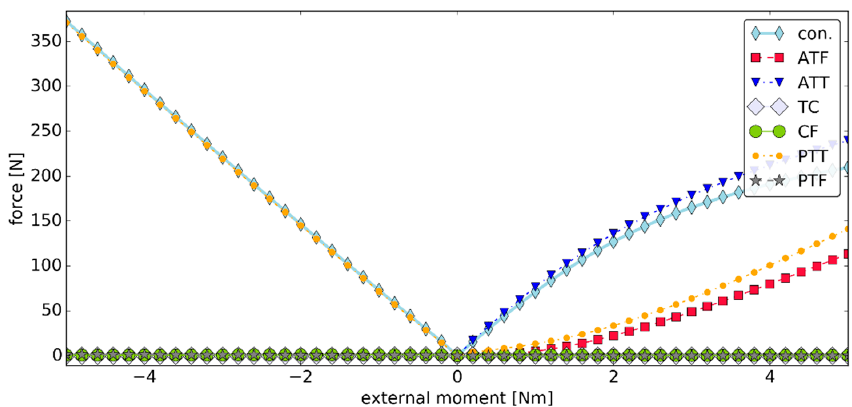
Figure 9. The values of the forces generated by the ligaments versus the external moment M ext in simulation #2, where "con." is the magnitude of the contact force generated by the two contact pairs.